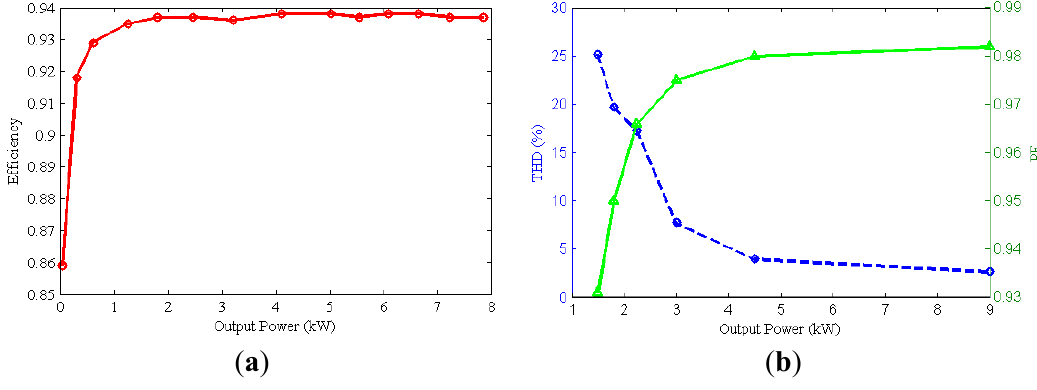
Figure 25. Measured efficiency, total harmonic distortion (THD) and PF curves: ( a ) efficiency; ( b ) THD and